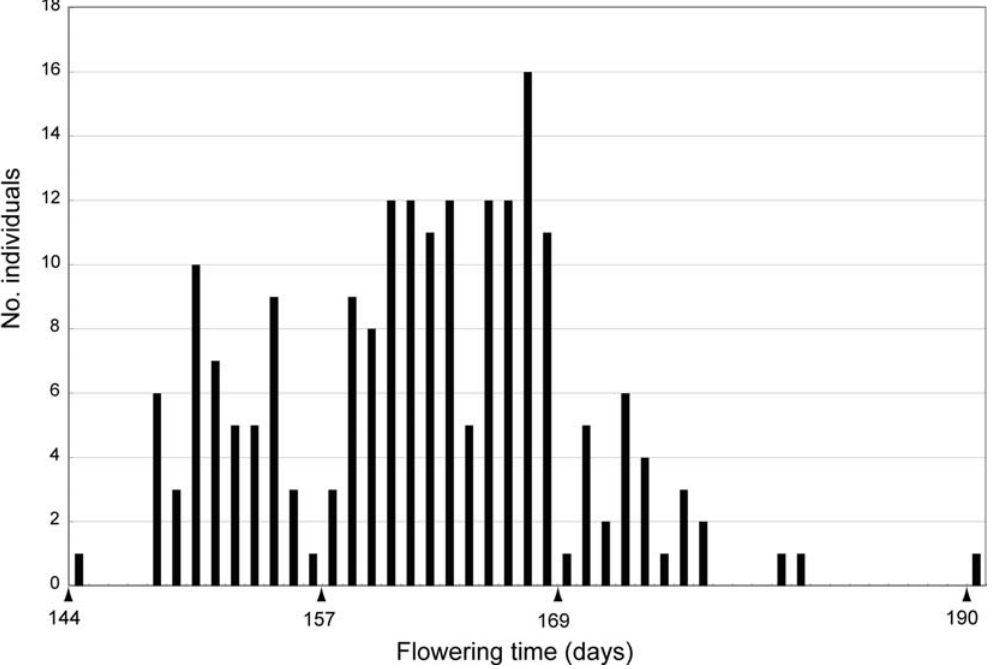
Figure 3. Flowering time variation in the 200 Ae.tauschii accessions. Flowering time for each accession is the mean of thrice-replicated data of days from germination to flowering.